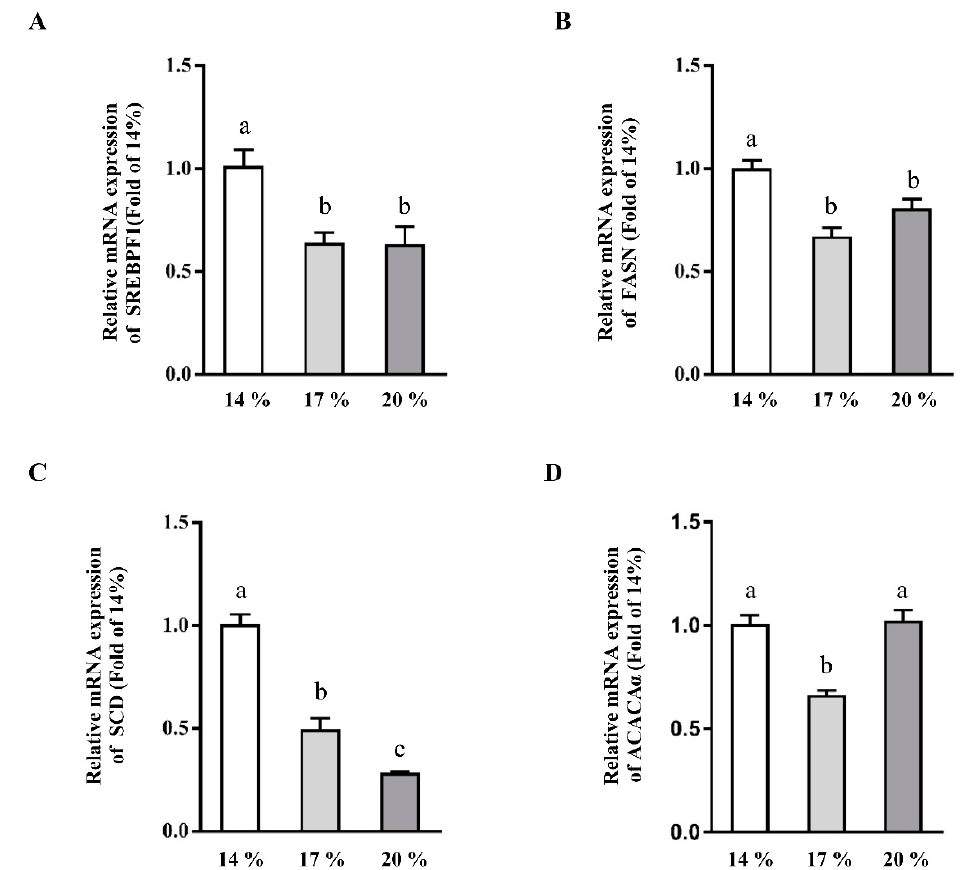
Figure 2. Effects of dietary crude protein level on hepatic lipogenesis genes expression. SREBPF1 ( A ), FASN ( B ), SCD ( C ), and ACAC α ( D ) mRNA expression in liver of weaned piglets fed different dietary crude protein. Values are means ± SEMs, n = 6. Means without a common letter differ, p < 0.05. SREBPF1, sterol regulatory element binding transcription factor 1; FASN, fatty acid synthase; ACAC α , acetyl-CoA carboxylase alpha; SCD, stearoyl-CoA desaturase.